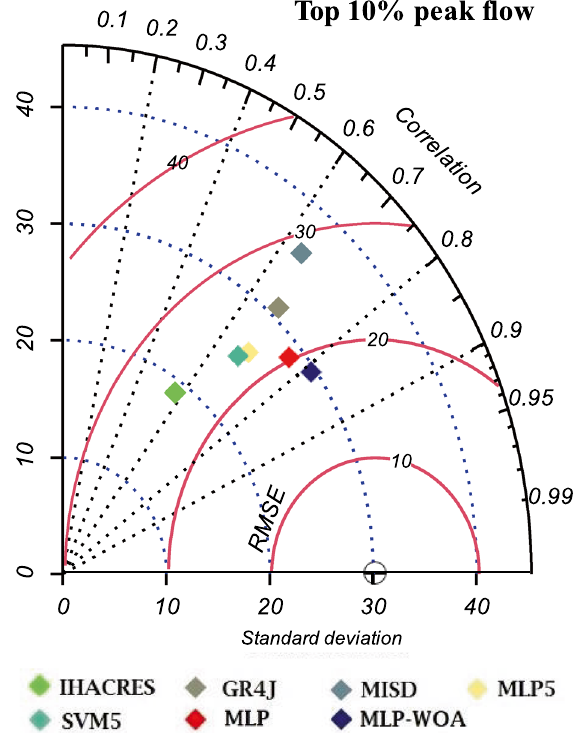
Figure 12. Taylor diagram of top 10% peak flow during the study period (1981–2021).